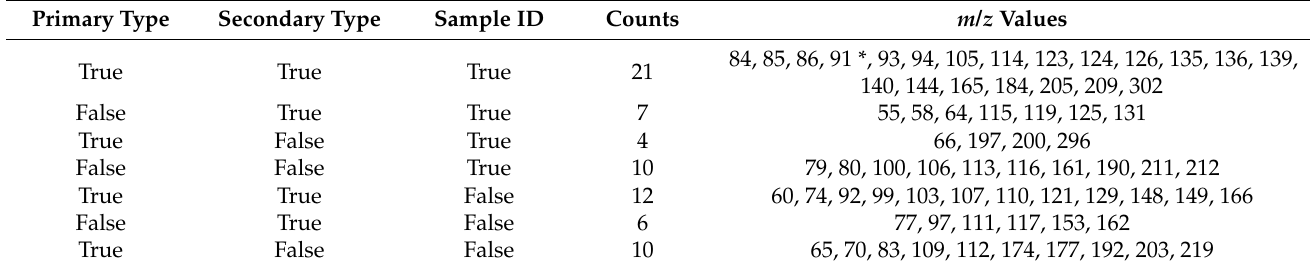
Table 3. Spectral features (ions) specific to classification problems using spectra before RUV correction. * indicates that for multi-layer perceptron classifier (MLP) classifier, 91 is replaced by